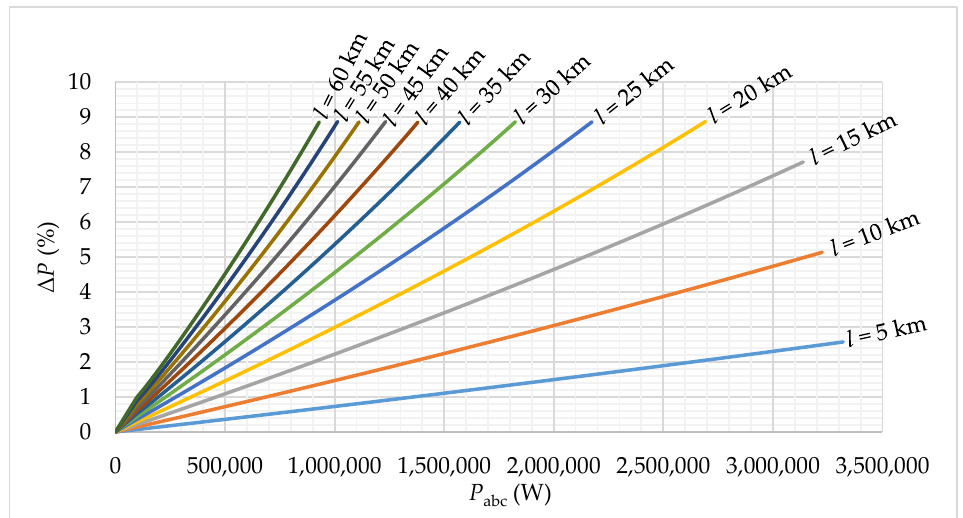
Figure 5. The dependence of increasing APLs from three-phase active power consumption for ACSR 42/7 with consideration of voltage dip.